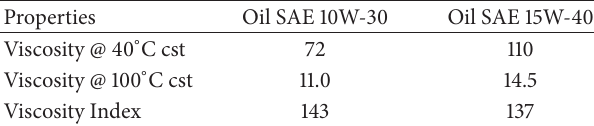
Table 2: Physical characteristics of both engine